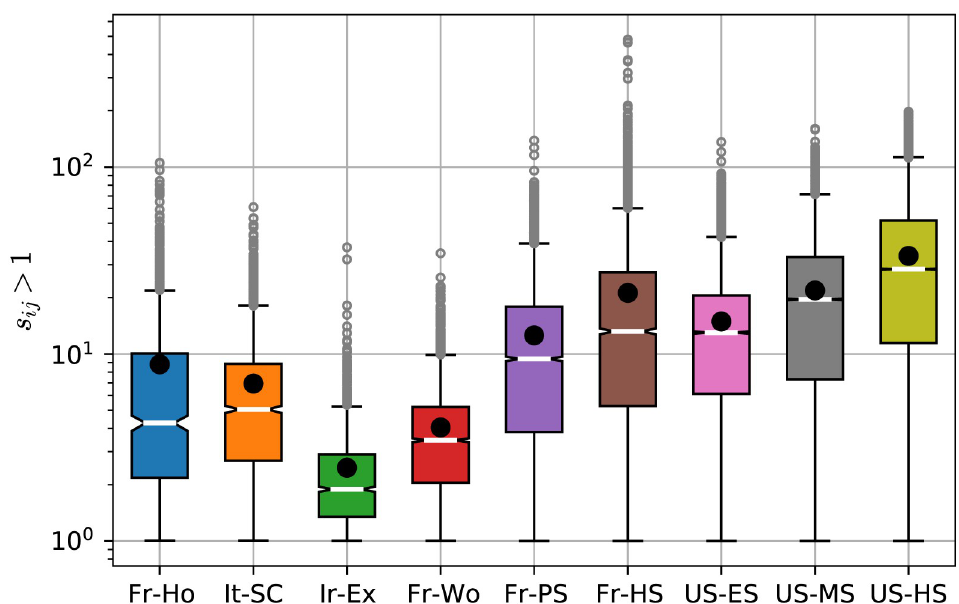
Fig 5. Distribution of semi-metric edge distortion for contact networks. Box plots of the distributions of semi-metric distortion for semi-metric edges ( s ij > 1) for all contact networks in Table 1. White bars and black circles denote the median and mean values, respectively. Actual distributions are shown in